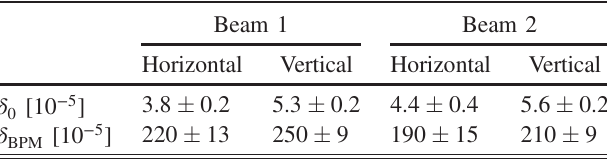
normalized to the transverse beam BPM